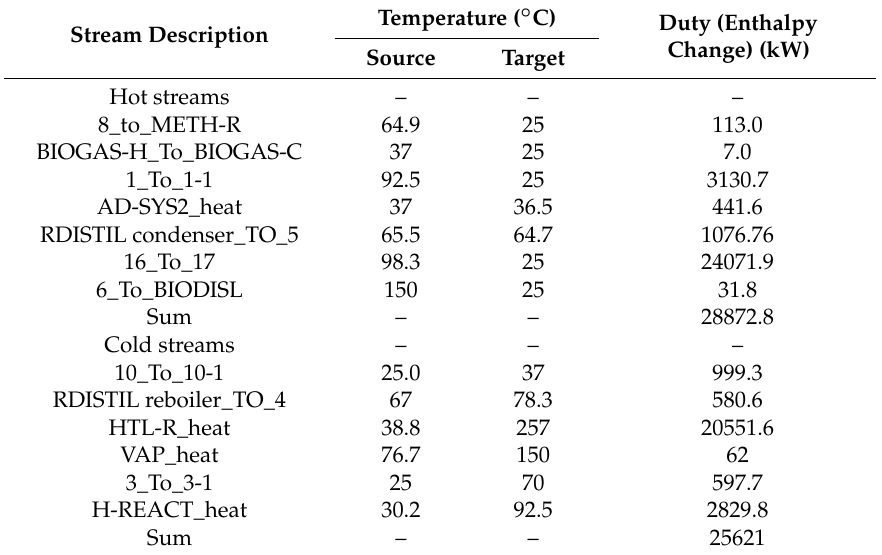
Table 2. Hot and cold streams extracted from the simulation datasheet sheet for the biorefinery process. Stream